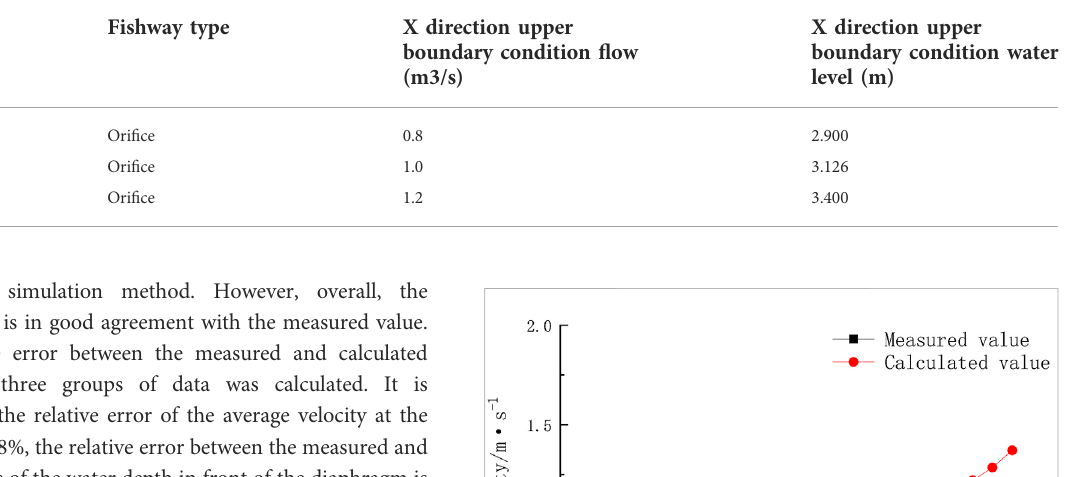
TABLE 4 Scenario design of ori fi ce fi shway numerical simulation.